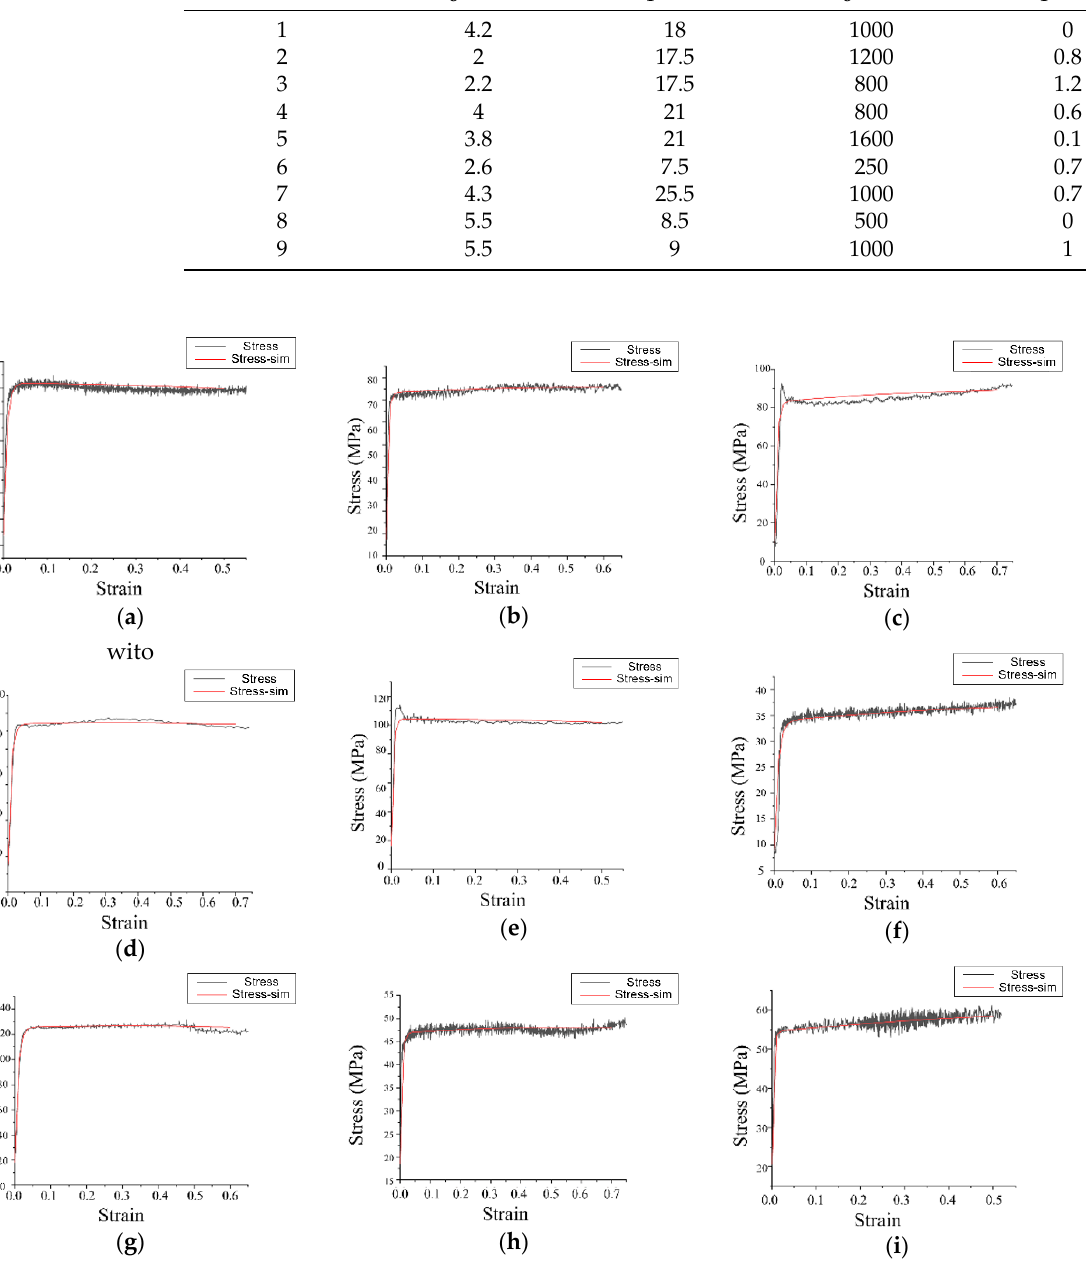
Figure 5. Stress – strain curve of AA7075 after hot deformation. (The subgraph captions ( a – i ) corre- spond to the experimental groups (1) to (9) in Table 2, respectively).